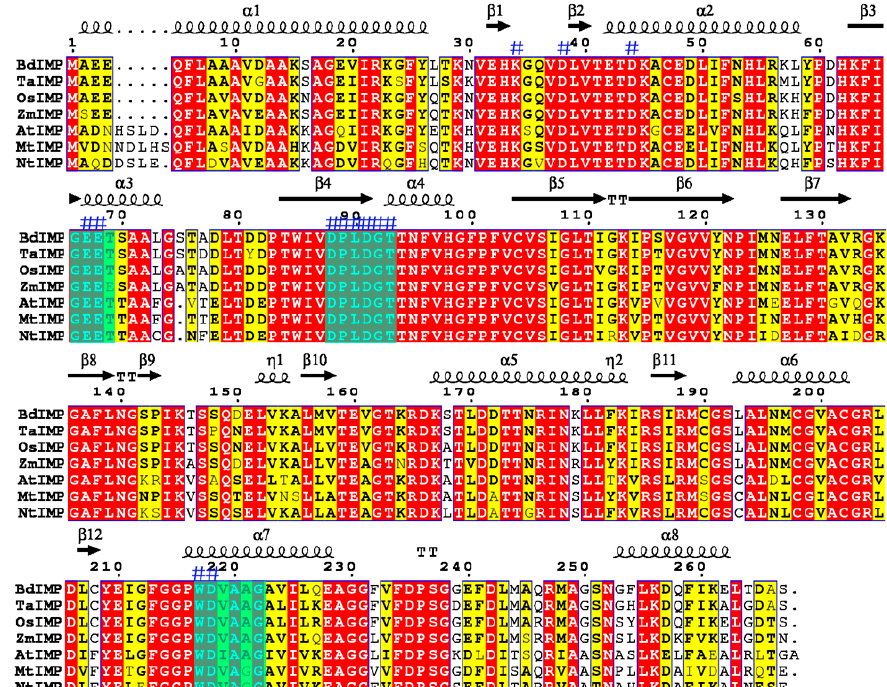
Figure 1. Multiple sequence alignments of L - myo -inositol monophosphatase (IMPase) from other plant species. Flat figure shows the sequences of IMPase from several plants. The second structure element symbols presented on the top (squiggles are α helices, arrows β strands and TT letters beta turns), identical and similar residues are boxed in red and yellow, respectively. Three characteristic signature motifs (GEET, DPLDGT and WDXAAG) of the phosphatase super family are boxed by purple colours. The enzyme active sites (i.e., lysine[K] 34 , aspartate[D] 38, 44, 88, 91, 218 , glutamic acid[E] 67, 68 , proline[P] 89 , leucine[L] 90 , glycine[G] 92 , threonine [T] 93 and tryptophan[W] 217 ) are marked by blue “#”. BdIMP, Brachypodium distachyon IMP; TaIMP, Triticum aestivum IMP; OsIMP, Oryza sativa (Gaogonggui) IMP; ZmIMP, Zea mays ; AtIMP, Arabidopsis thaliana IMP; MtIMP, Medicago truncatula IMP; NtIMP, Nicotiana tomentosiformis IMP.